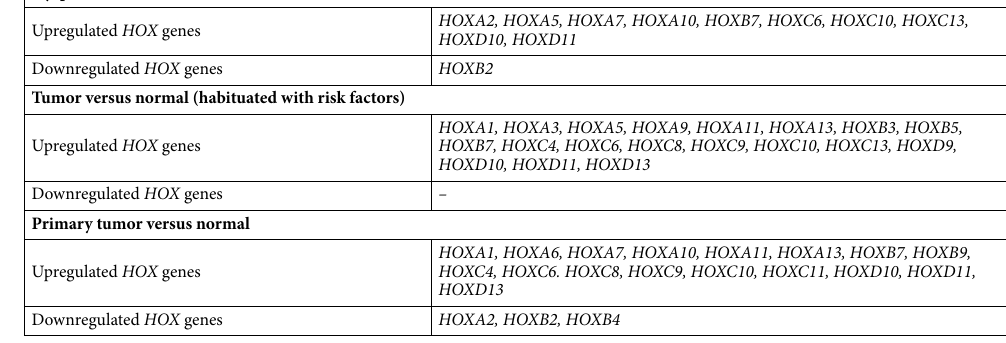
Table 1. List of differentially upregulated and downregulated HOX genes in a panel of normal, dysplastic and primary tumor through the disease progression of oral